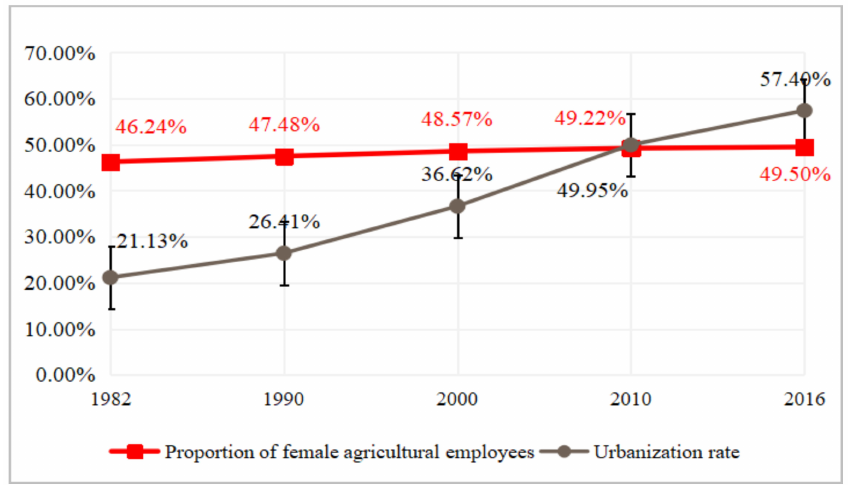
Figure 1. Changes in the urbanization rate and the proportion of female agricultural employees